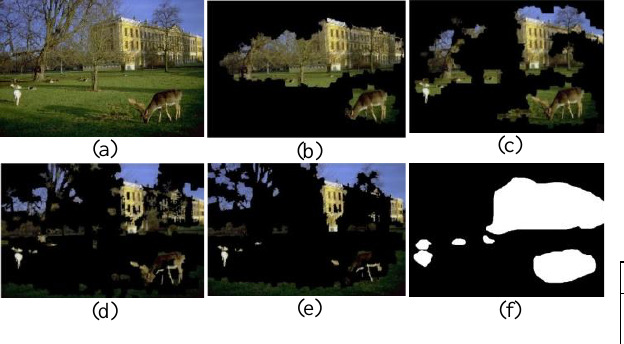
Figure 7. (a) original image (b) SS&KD, (c) Rare2012, (d)